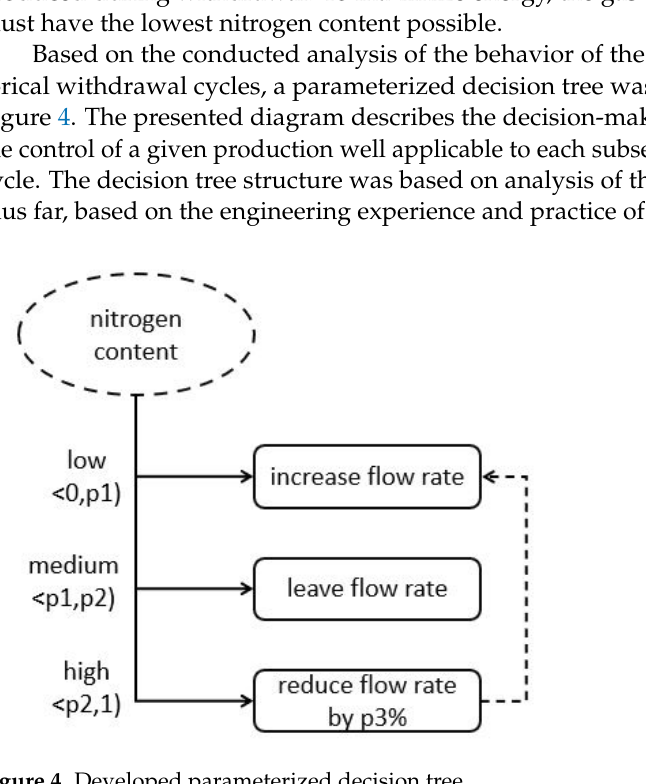
Figure 4. Developed parameterized decision